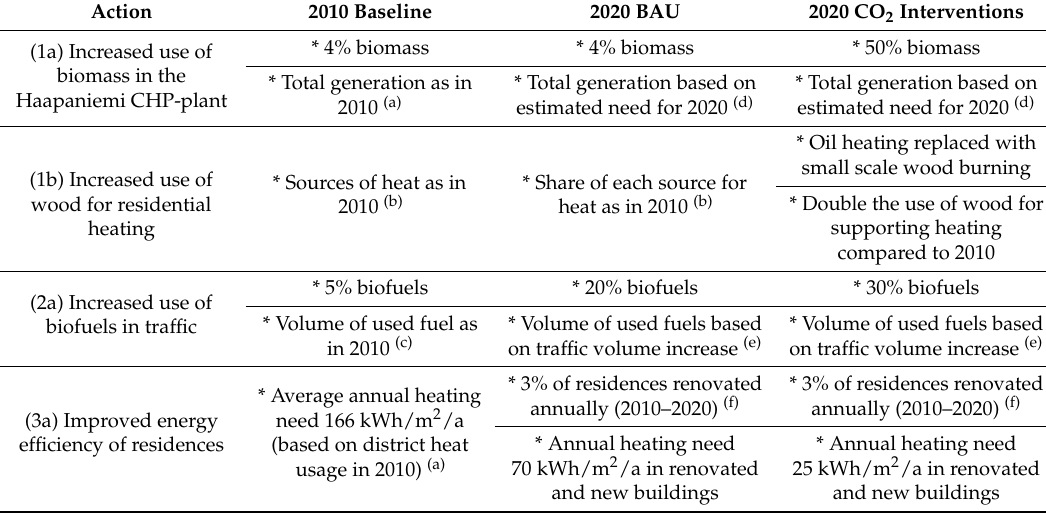
Table 1. Assumptions for each scenario and description of the changed